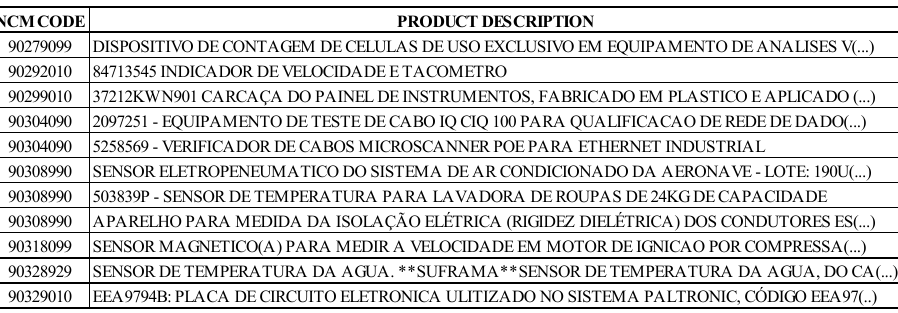
Figure 5. Chapter 90 import data sample [14].